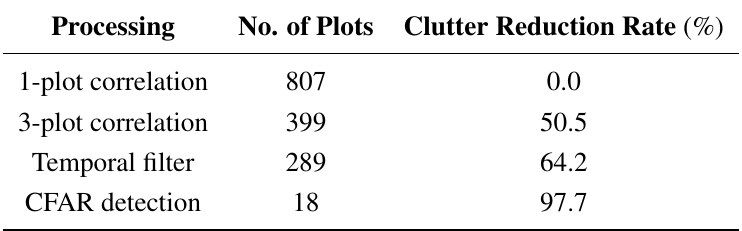
Table 2. Clutter reduction performance for each spatio-temporal processing